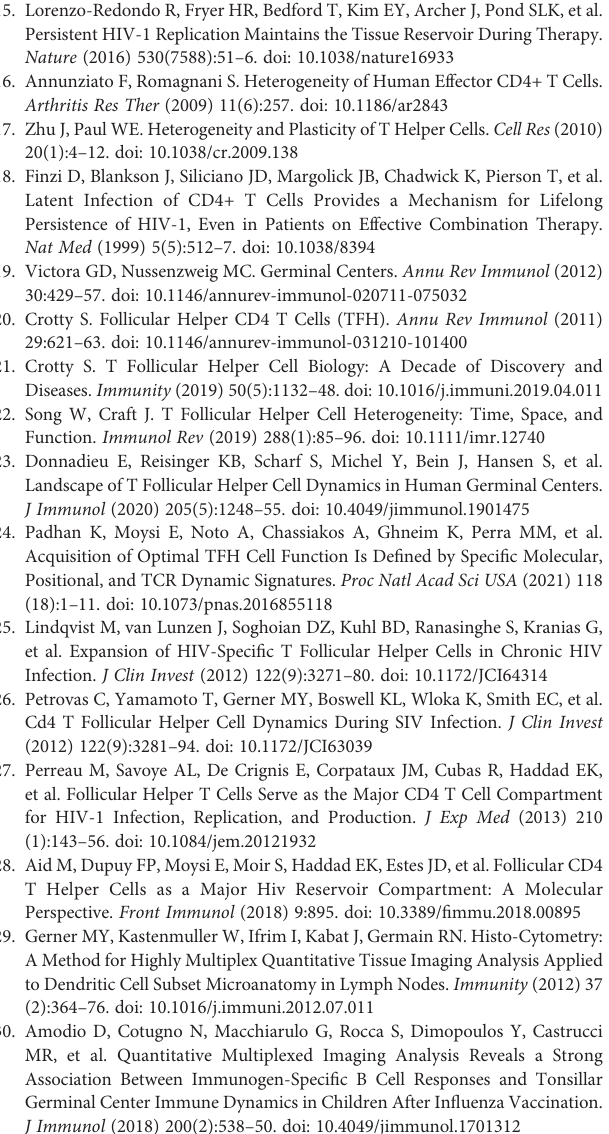
to establish the speci fi city of the detected signals in each channel. Fluorescence in the FMO channel was detected only when the corresponding antibody was present but not when omitted or replaced by an isotype control. Images were acquired at 40x (NA 1.3) with 1% zoom. Scale bars = 500um, 50um (close-ups). Supplementary Figure 4 | Fluorescence acquisition spectral regions and cross- talk among acquisition channels. (A) Schematic showing the lasers, fl uorochromes used and photon detection regions used for image acquisition in the eight multispectral panels described in this study. Regions were adjusted after acquiring real-time single fl uorochrome emission curves to maximize signal-to-noise ratios and minimize cross-talk between channels. (B) Representative example of single fl uorochrome emission cross-over into neighboring channels as detected after staining for BV421, JOPRO-1, eF615, AF488, AF546, AF647, BV480 or AF700. Each horizontal line corresponds to a single fl uorochrome that was acquired under the same conditions as the full panel in order to visualize and resolve potential fl uorescence cross-over issues. Images were acquired at 40x (NA 1.3) with 1% zoom. Scale bars are